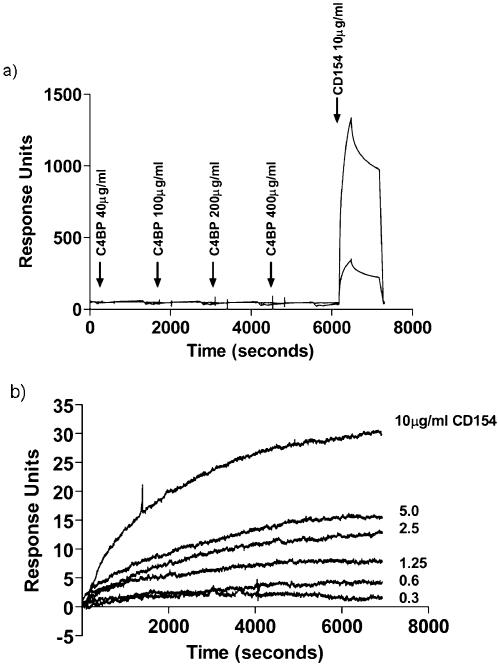
Biacore analysis – Panel a) This figure shows the sensogram trace for the titration of C4BP binding across immobilised CD40. CD40 fusion protein was immobilised on an activated CM5 chip, to yield 2000, 500 and 100 response units on three separate channels. Soluble C4BP was then flowed across the surface of the chip at increasing concentrations. The chip was regenerated between the different concentrations using 2M glycine. No binding or dose-response was seen. The integrity of the CD40 was confirmed by the determining the ability of the receptor to subsequently bind sCD154. Panel b) This figure shows the sensogram for sCD154 binding to immobilised C4BP. C4BP was immobilised on an activated CM5 research grade chip. sCD154 was then flowed across the chip at increasing concentrations up to 10 ug/ml. The chip was regenerated between concentrations using 2 M glycine. Dose dependent binding of sCD154 was observed across the concentration range. No binding was observed with an irrelevant fusion protein (data not shown).